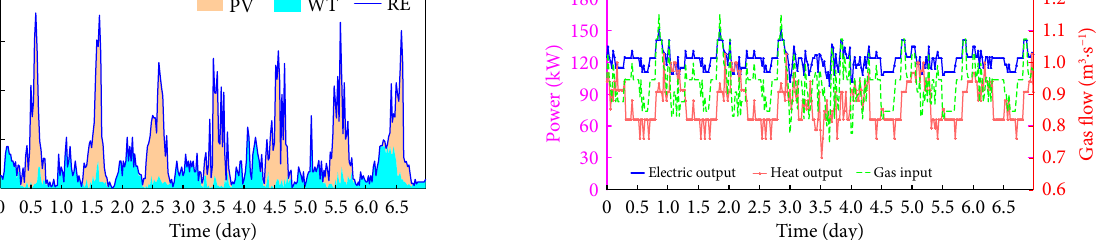
Fig. 9 Generated operating characteristics of RE.